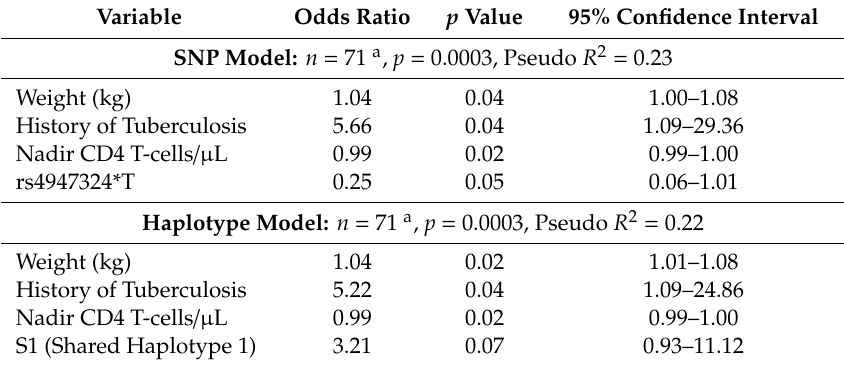
Table 4. Logistic regression modelling identified rs4947324*T in Africans as an independent marker of susceptibility to